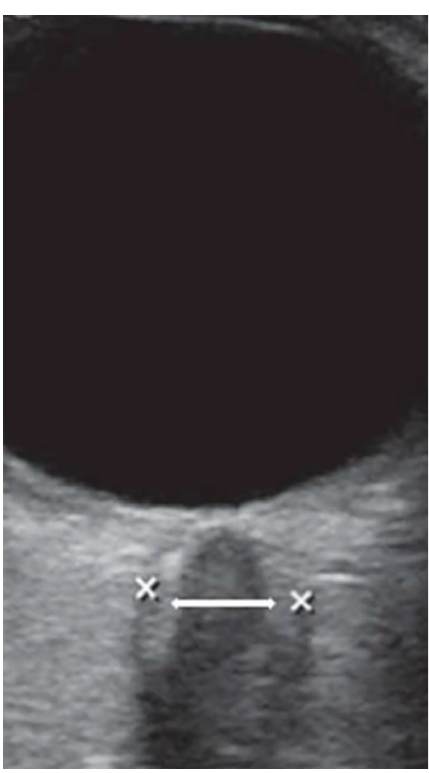
Figure 1: Employment of the “black stripe” method (white arrow) may underestimate the actual optic nerve sheath diameter (ONSD) measurement ( x – x ) based on the new sonographic quality criteria in patients with increased intracranial